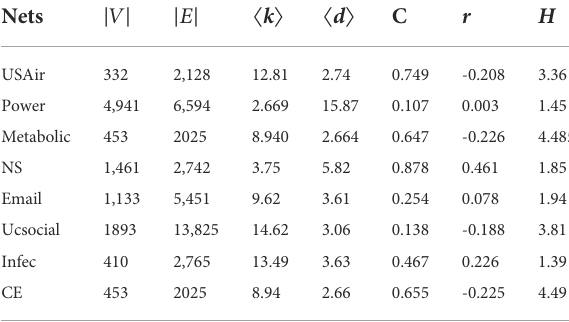
TABLE 1 Twelve benchmark networks ’ fundamental topological